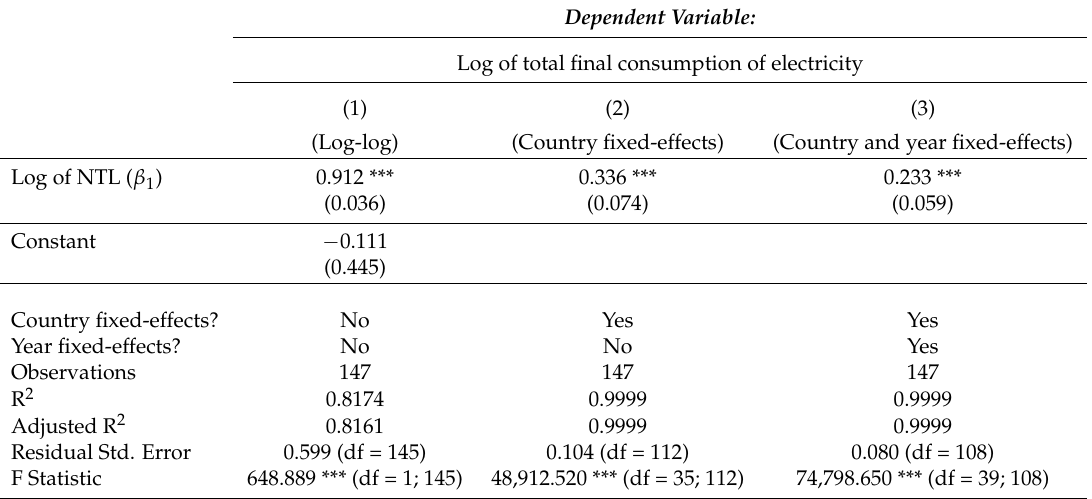
Table 4. Lower-middle income countries regression for